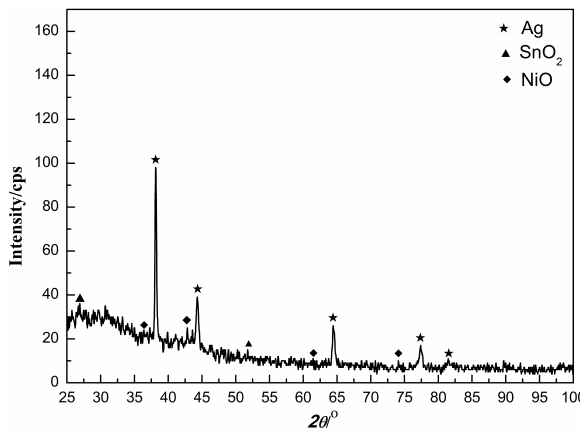
Figure 1: XRD pattern of AgSnO 2 NiO composites with NiO content of